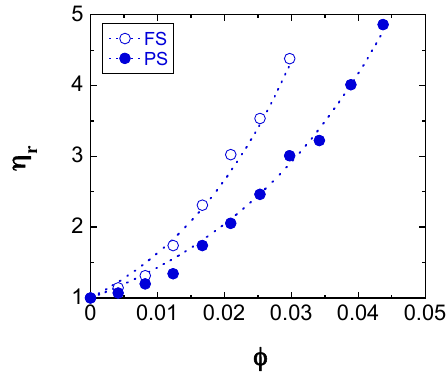
Figure 7. The relative viscosity values of the FS (open blue circle) and PS suspensions (filled blue circle) at the shear rate of 10 3 s − 1 as a function of φ . The dashed lines represent fit to the Krieger and Dougherty equation.